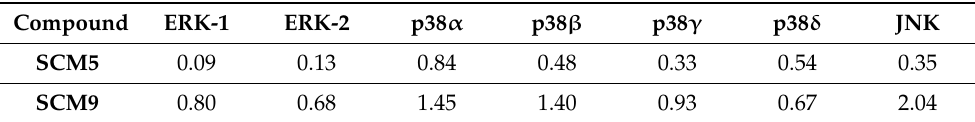
Table 5. E ff ect of SCM compounds on MAP kinase expression in Jurkat cells. Glyceraldehyde-3 -phosphate dehydrogenase (GAPDH) was used as a housekeeping gene to normalize values obtained for the target genes. The dimensionless values presented in the table reflect relative fold changes in response of the cells to SCM compounds, when the GAPDH gene expression was a control and assumed as equal to one.